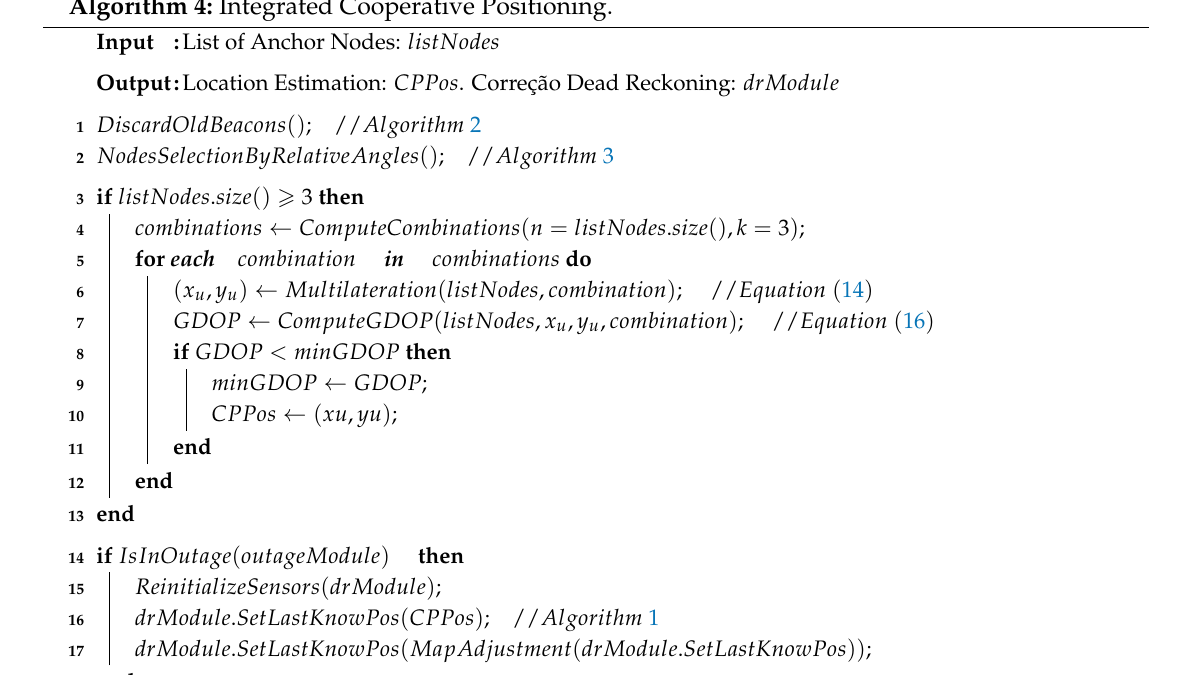
Algorithm 4: Integrated Cooperative Positioning.